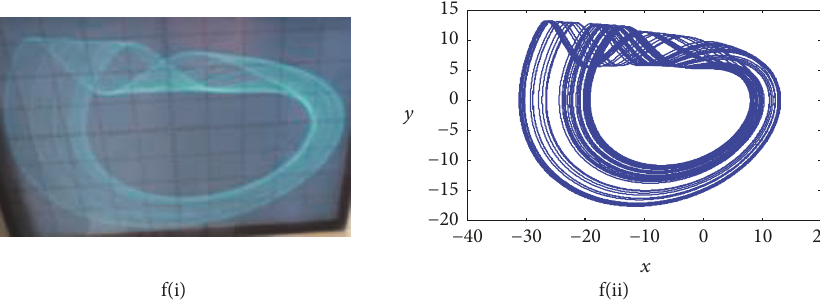
Figure 9: Experimental phase portraits (left) obtained from the circuit using a dual-trace oscilloscope in 𝑋𝑌 ; the corresponding numerical phase portraits (right) showing the period-doubling routes to chaos in the system for varying 𝑅 3 ( i.e., 𝜇) : (a) period-1 cycle for 𝑅 3 = 60.3 k Ω ( i.e., 𝜇 = 0.165) ; (b) period-2 cycle for 𝑅 = 26.2 k Ω ( i.e., 𝜇 = 0.381) ; (c) period-4 cycle for 𝑅 = 25.97 k Ω ( i.e., 𝜇 = 0.385) ; 3 3 (d) spiralling-like (Feigenbaum) chaotic attractor for 𝑅 3 = 24.60 k Ω ( i.e., 𝜇 = 0.406) ; (e) screw-like (Shilnikov) chaotic attractor for 𝑅 = 23.81 k Ω ( i.e., 𝜇 = 0.420) ; (f) another screw-like (Shilnikov) chaotic attractor for 𝑅 = 9.09 k Ω ( i.e., 𝜇 = 1.100) 3 3